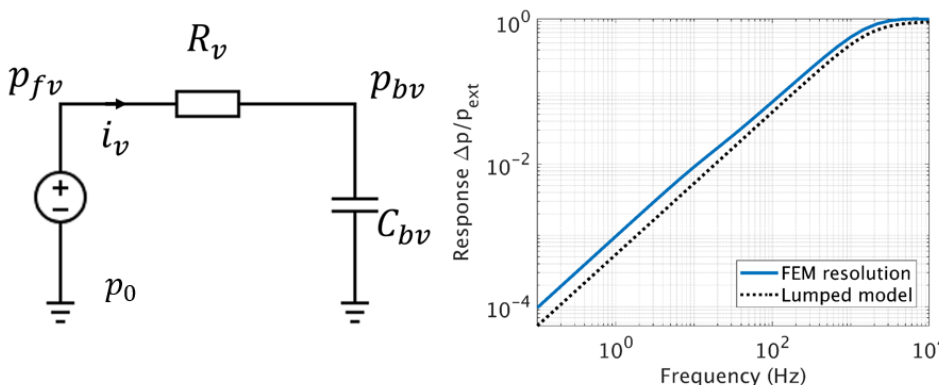
Figure 7. On the left, equivalent electrical circuit responsible for the pressure differential across the slit, given an applied pressure p ext . On the right, transfer function of the circuit and comparison with the FEM simulation using the FLNS model.